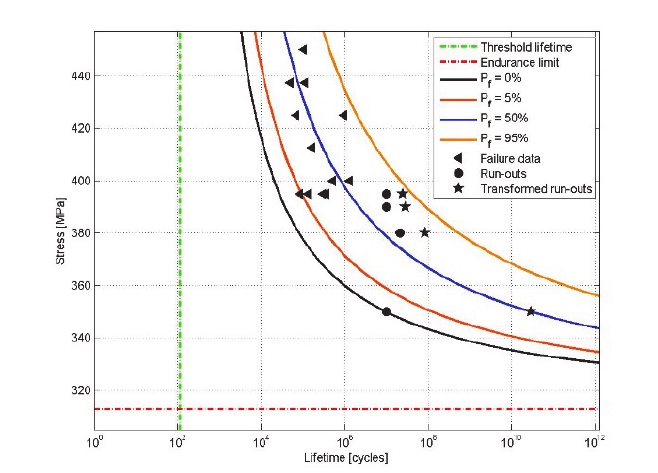
Figure 2: S-N field assessment using the Profatigue software